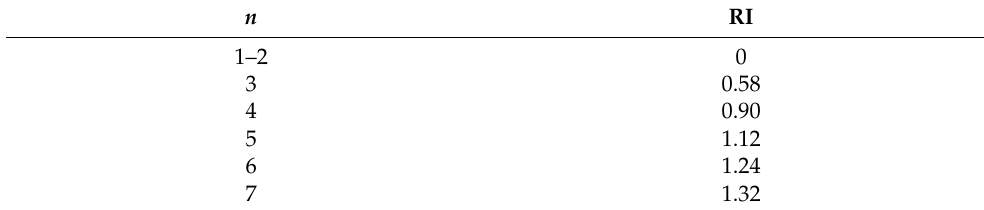
Table 3. RI values for different n